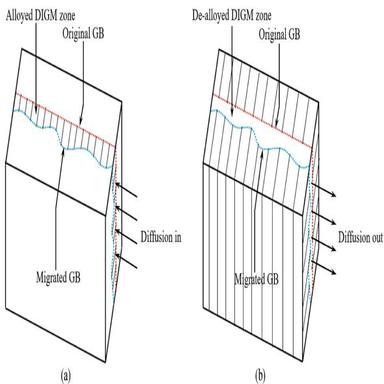
Schematic images of DIGM in a region of a GB. (a) Solute atoms are deposited during DIGM, and the GB migrates while leaving behind an alloyed zone. (b) Solute atoms are removed during DIGM, and the GB migrates while leaving behind a de-alloyed zone.